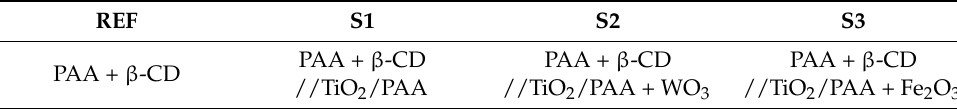
Table 1. Summary table of the analyzed samples.